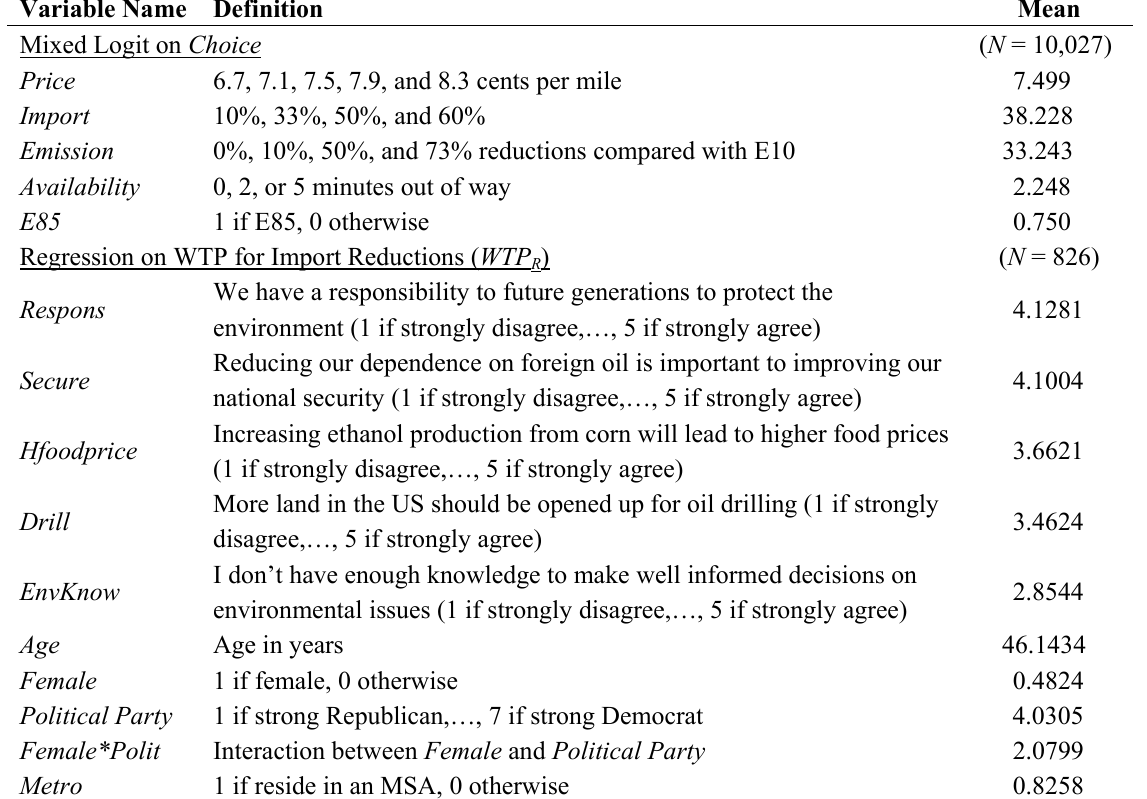
Table 1. Names, definitions, and means of variables used in the